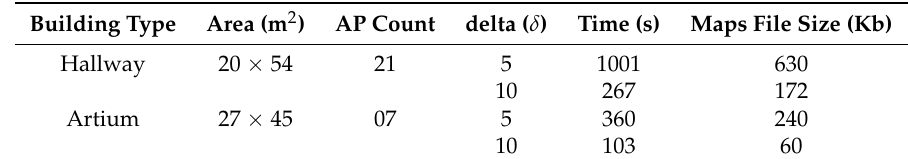
Table 2. Statistics of the change in the time and memory required on the disk for map generation with respect to the area and number of Access Points.